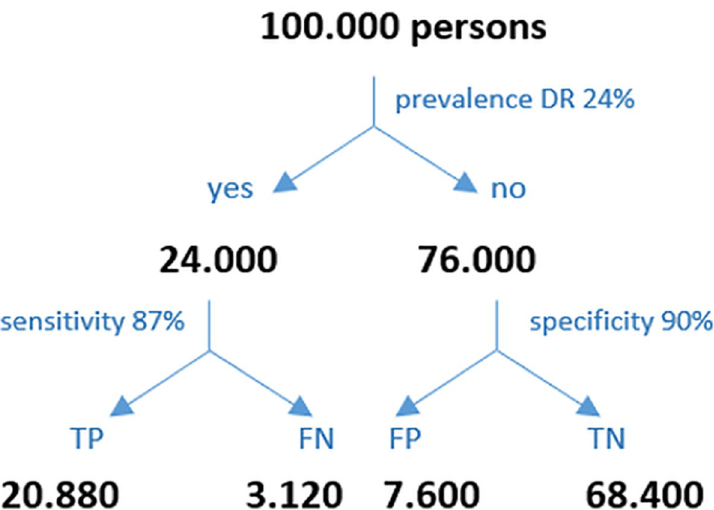
ppv = TP/(TP+FP) = 73% of all positively tested diabetes patients, 73% have a true DR and 27% do not. npv = TN/(TN +FN) = 95% of all negatively tested diabetes patients, 95% are truly negative and 5% are not.